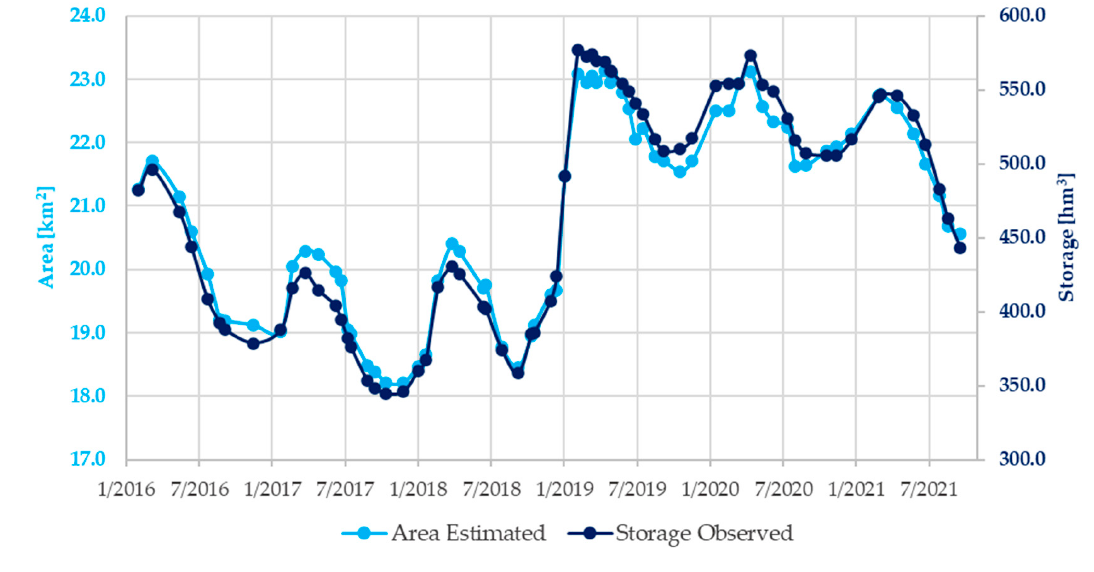
Figure 3. Sentinel-2-derived Yliki reservoir water area and observed storage time series.